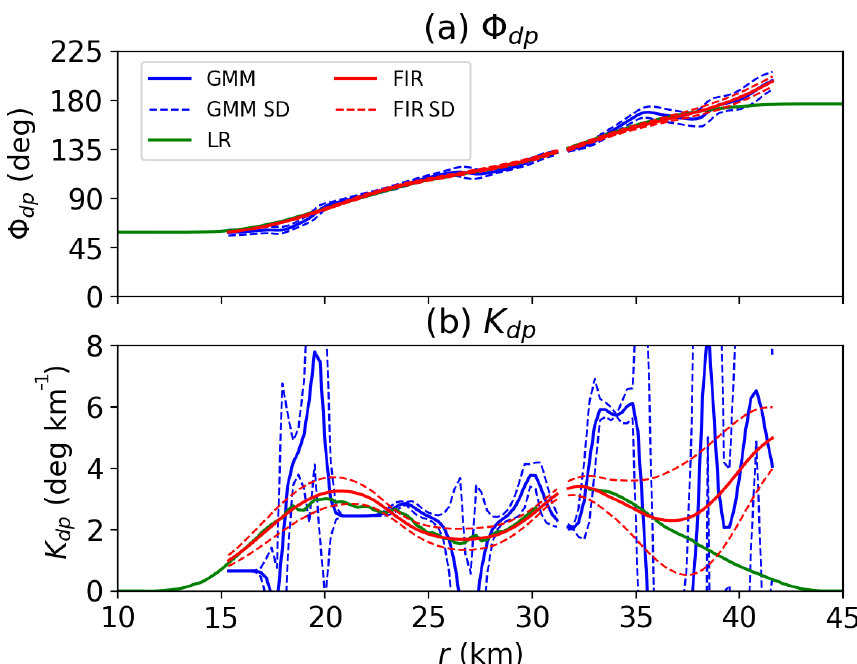
Figure 6. Examples of K dp estimation: (a) (cid:56) dp and (b) K dp . The blue curves are the (cid:56) dp and K dp estimates obtained by the Gaussian mixture method (GMM), the green curves represent the estimates derived from the linear regression model (LR), and the red curves indicate the reconstructed (cid:56) dp and smoothed K dp profiles (FIR). The dashed lines are the standard deviations.